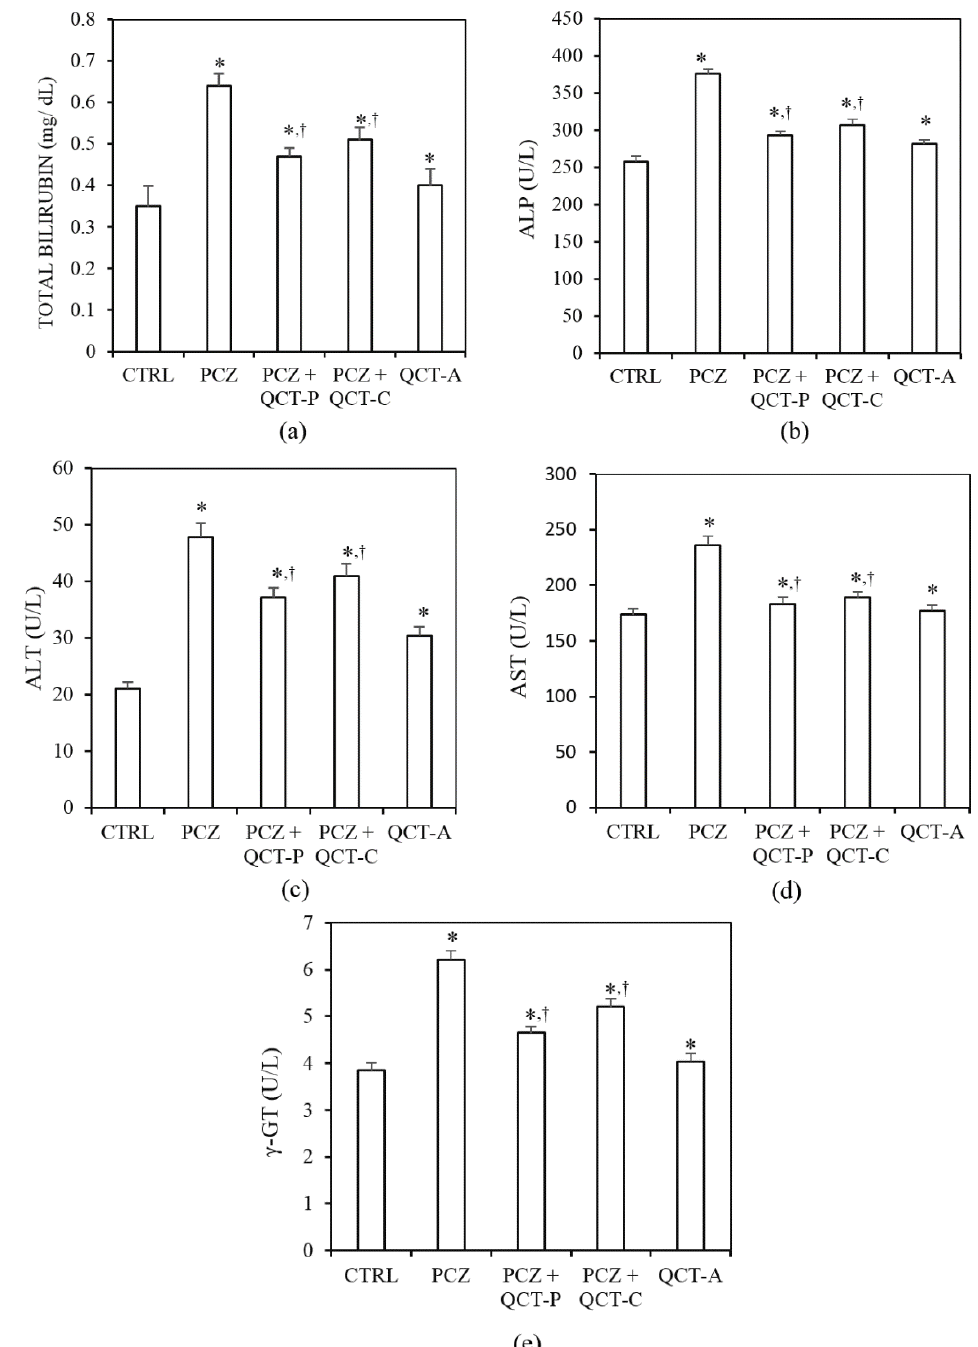
Figure 3. Protective effect of QCT pre-treatment and co-treatment against PCZ-induced changes in biomarkers of hepatotoxicity in rats. Data represent the means ± SD for five rats in each group; * significantly different from the CTRL; † significantly different from PCZ ( P < 0.05)